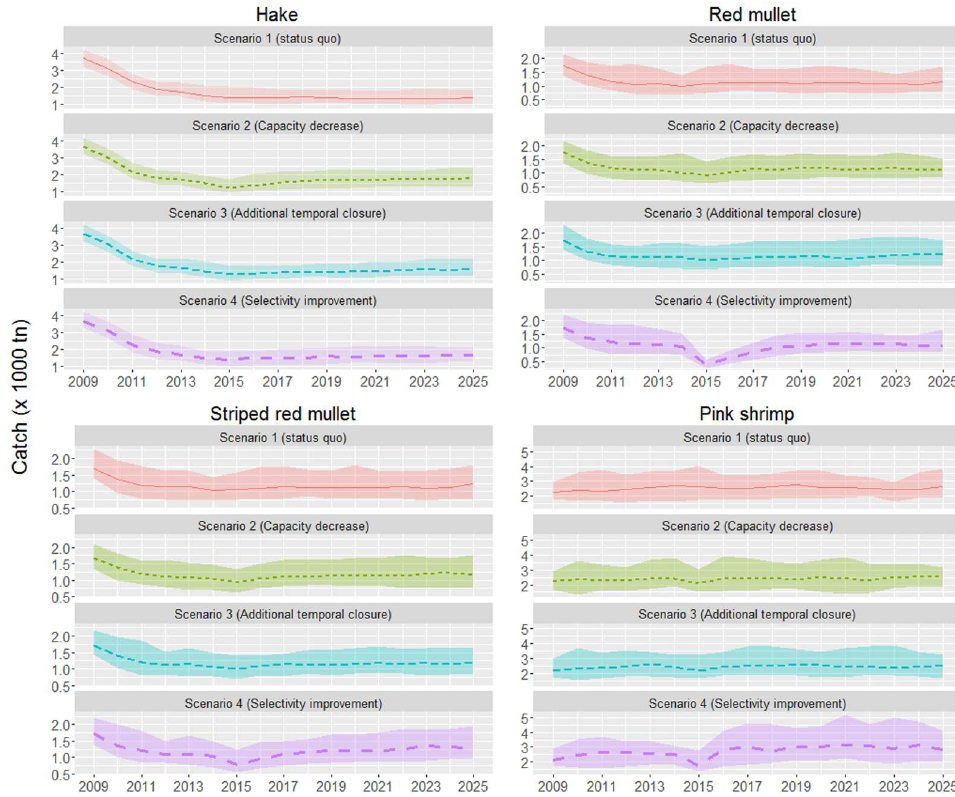
Fig 3. Catch by species (in 10 3 tons) under the four simulated scenarios. Dotted lines indicatethe median estimates and the upper and lower limits of each ribbonrepresent the 0.1 and 0.9 quantiles.